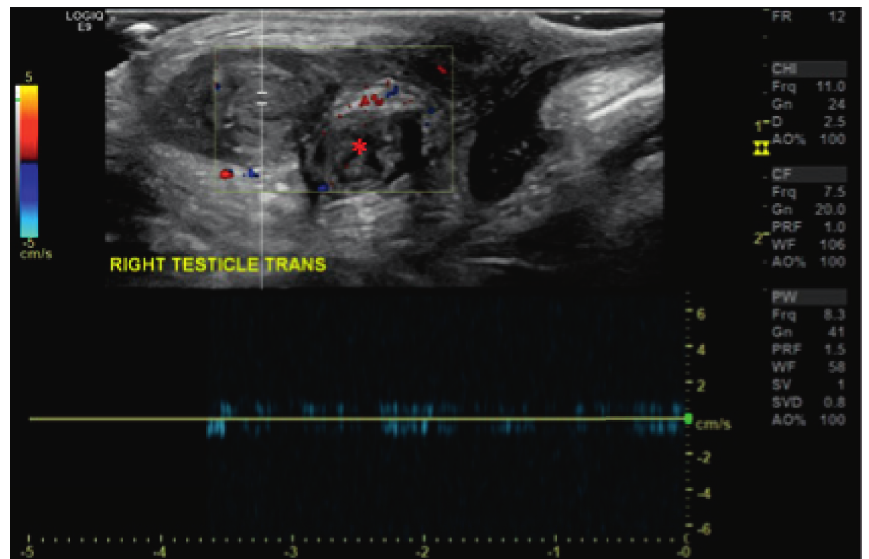
Figure 2: Sagittal view of immediate postnatal color Doppler ultrasonography demonstrating the absence of testicular blood flow and accompanying changes including “whirlpool” sign